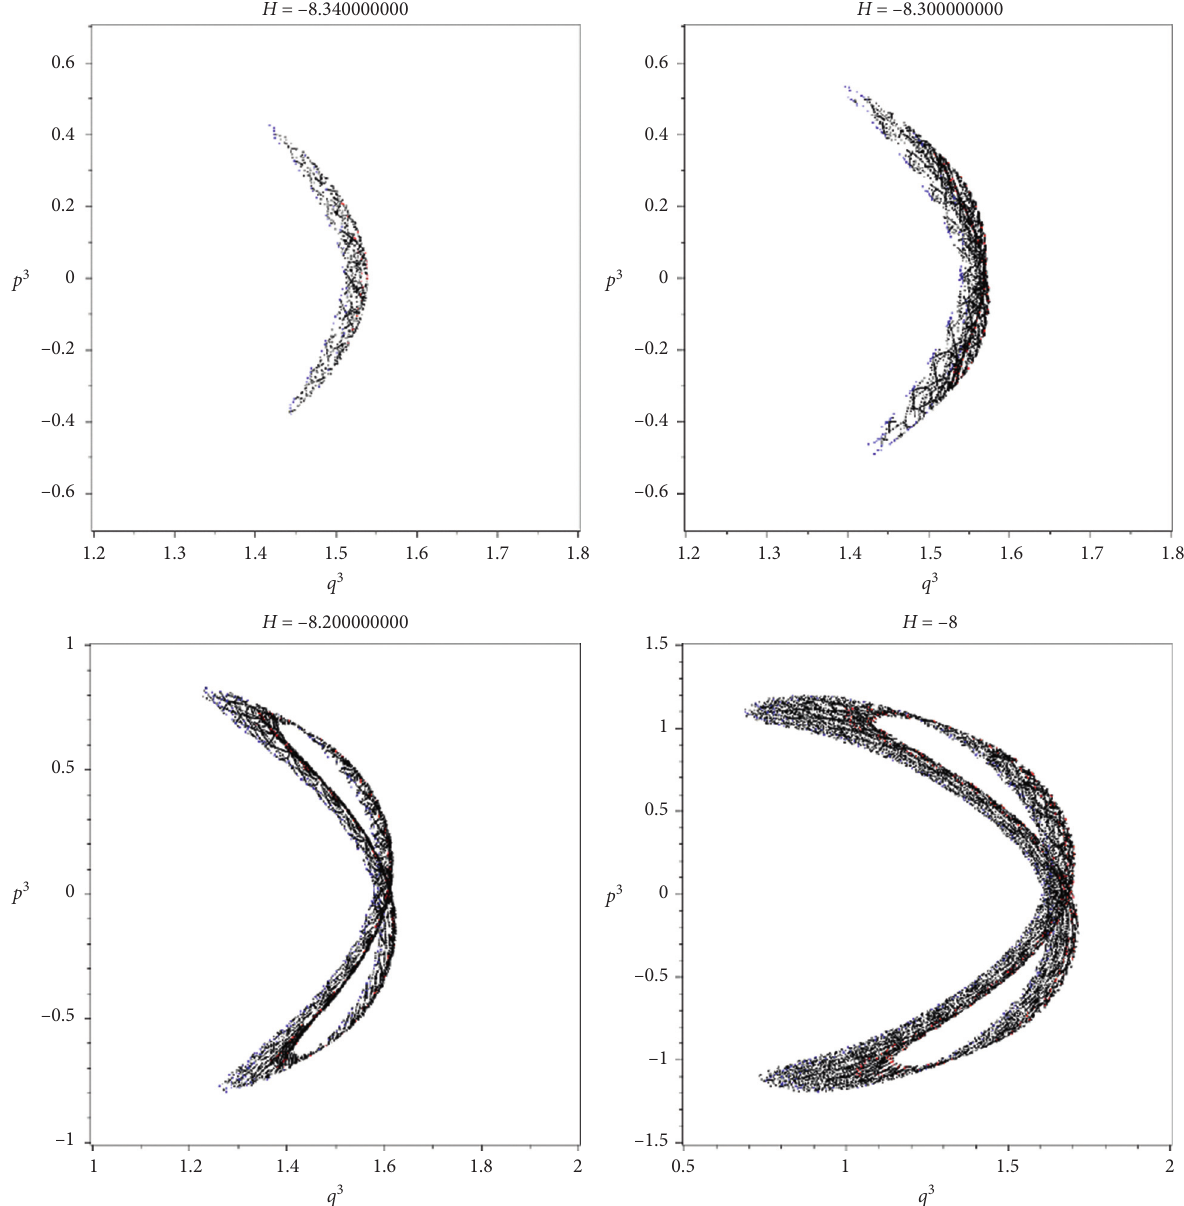
Figure 12: The progressive changing of a Poincar´e surface of sections for different energy levels in the unequal masses case ( m m � 1 . 03, m � m � 1, b � 1 . 9, and c � 0 . 2 3 1